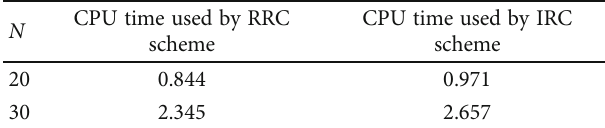
Table 9: Comparing the CPU time used by seconds for RRC and IRC schemes λ = − 1